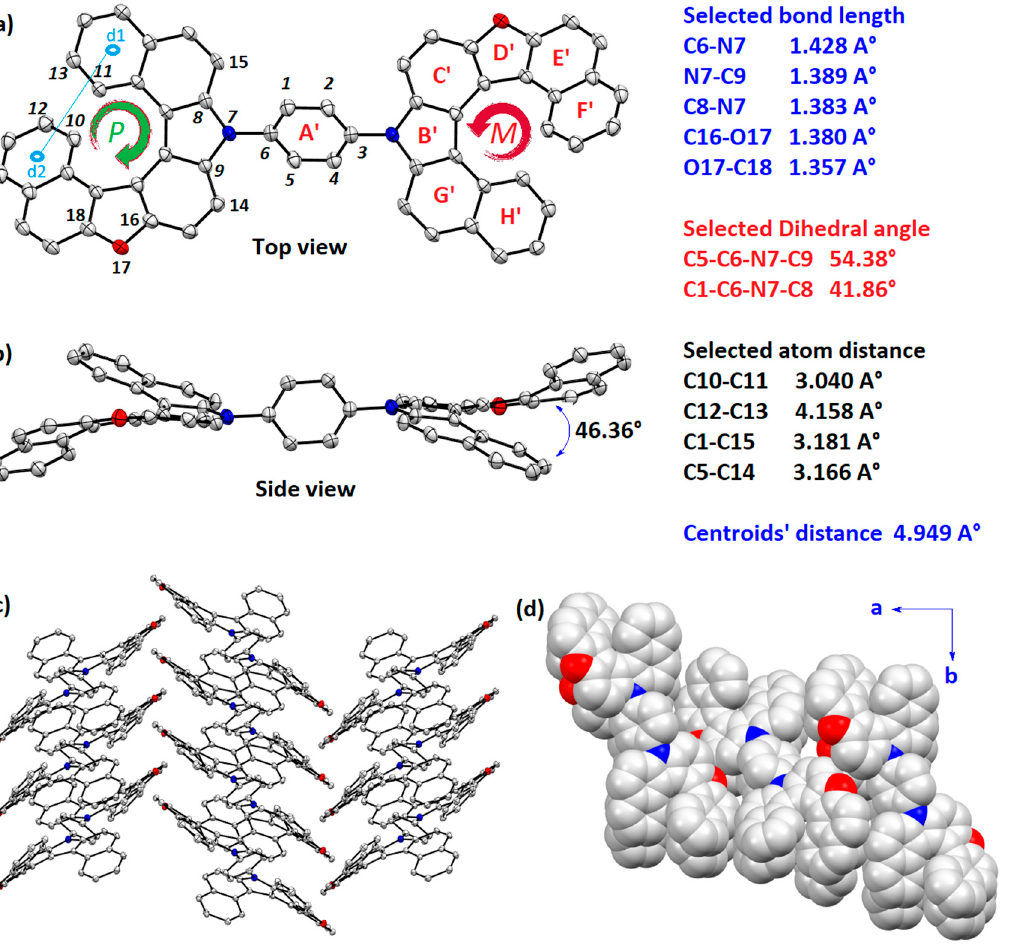
Figure 2. Single crystal structure of the double helicene 3 : ( a , b ) ORTEP drawing structure of ( P , M )- 3 obtained by X-ray crystal analysis with ellipsoids at 50% probability (H atoms were omitted for clarity); ( c ) crystal packing of ( P , M )- 3 with ellipsoids at 30% probability; ( d ) packing structure of ( P , M )- 3 is viewed along the c-axis to show the herringbone arrangement.